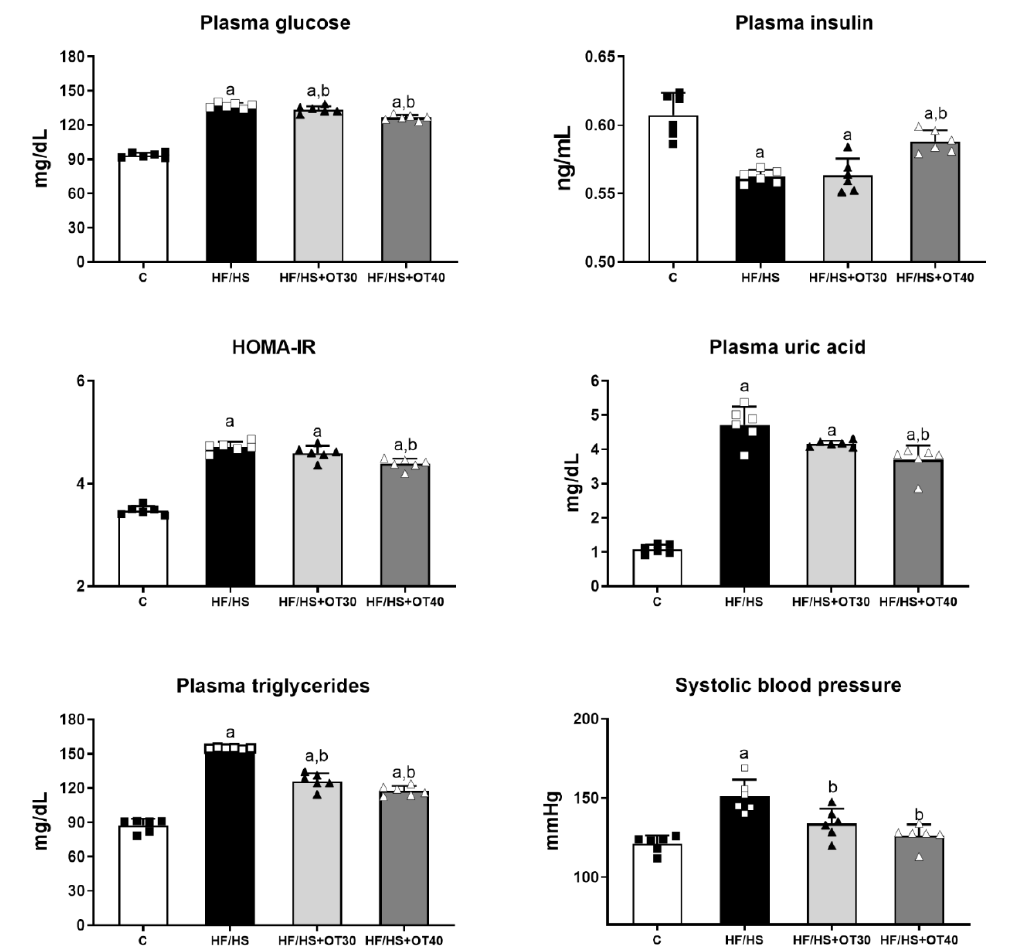
Figure 3. Systemic and renal effects of HF/HS diet. Plasma levels of glucose, insulin, uric acid, triglycerides, blood pressure, and homeostasis model assessment–immunoreactivity (HOMA-IR) values. Results are presented as the mean ± SD and analyzed by one-way ANOVA. Post hoc analysis was performed using Bonferroni’s test. a: p < 0.05 vs. C; b: p < 0.05 vs. HF/HS.